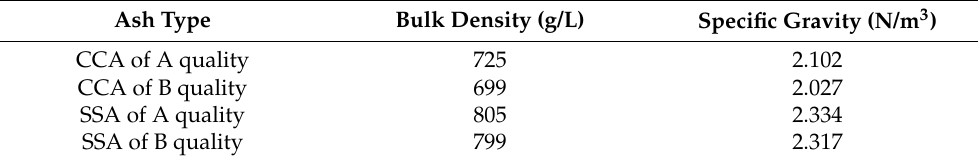
Figure 1. The SSA of A and B quality and CCA of A and B quality, compared with the cement aspect. The vegetal material that did not passed through the 300 µ m sieve was subjected to supplementary thermal treatment at around 550 ◦ C for 120 min. After this treatment, the vegetal material was sieved again through 20 mm, 10 mm, 2 mm, and 300 µ m sieves for 5 min, with the same sieving equipment, and then ground for 120 min in the ball dust crusher. This ground ash (Figure 1) was noted as B quality ash and it was used as cement partial replacement in CCA1B, CCA2B, SSA1B, and SSA2B concrete mixes. The ashes’ bulk density and specific gravity are presented in Table 1. Table 1. The bulk density and specific gravity of CCA and